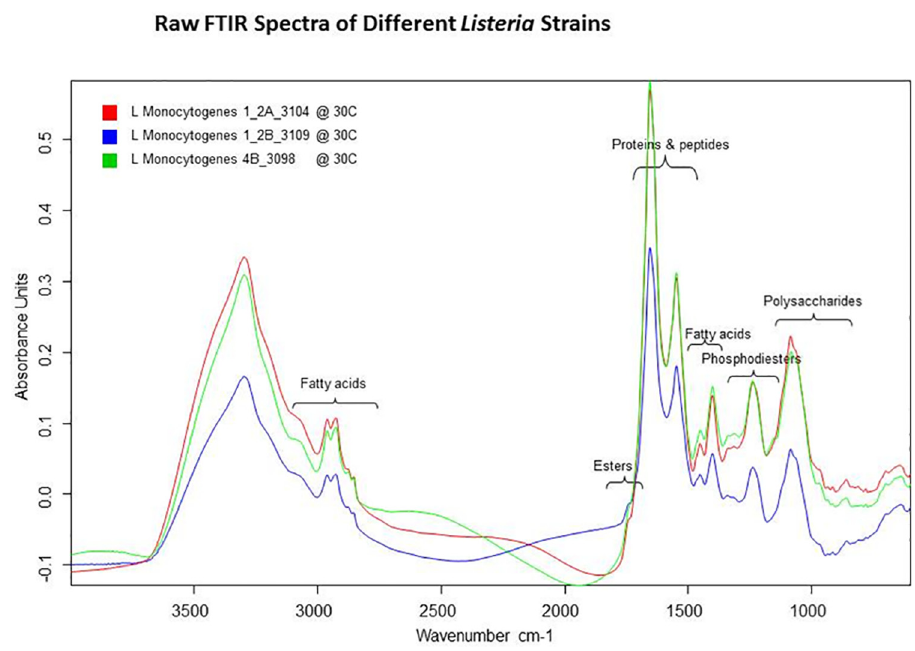
Fig 2. Raw FT-IR data showing three serogroups of Listeria monocytogenes . All strains were grown at 30°C. The spectral window shown is from x-minimum to 4,000 cm -1 .